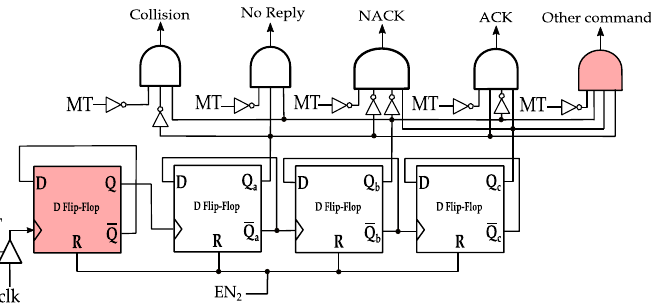
Figure 9. MCI process in anti-collision protocols with PIE encoding to accommodate MCI commands and other commands that are sent explicitly not through the MCI.